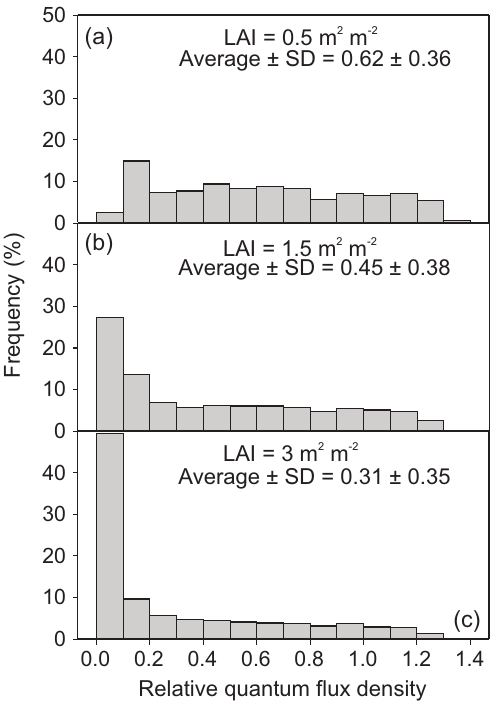
Fig. 3. Frequency distribution of light intensity on leaf surface within branch enclosures including progressively more leaf area. As a measure of leaf area enclosed in the measurement chamber, branch leaf area index, i.e. leaf area per unit flat surface area, is used. Light intensity relative to the intensity on a flat surface above the branch is computed for a solar angle of 45 ◦ and assuming 80% of direct radiation. The simulation was performed with a ray trac- ing model for circular flat leaves having a spherical leaf angle dis- tribution and random dispersion (Cescatti and Niinemets, 2004 for details). The gradients of light are expected to be even stronger for aggregated foliage dispersions as is common in most conifers (Cescatti and Zorer, 2003; Niinemets et al.,